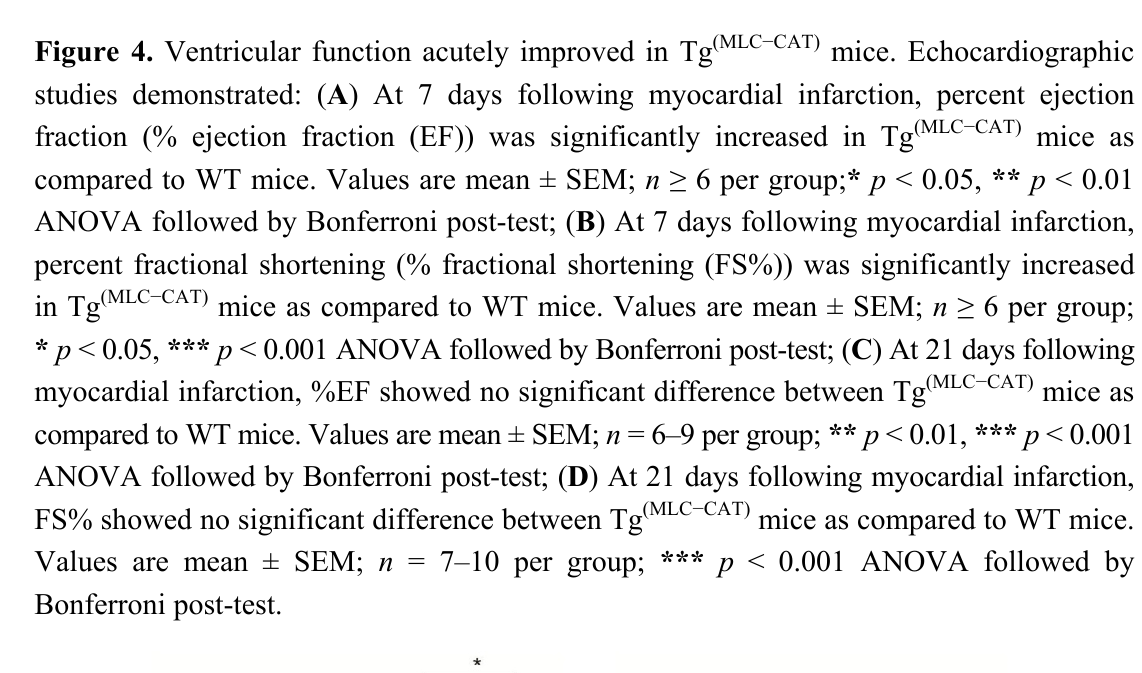
Figure 4. Ventricular function acutely improved in Tg (MLC − CAT) mice.